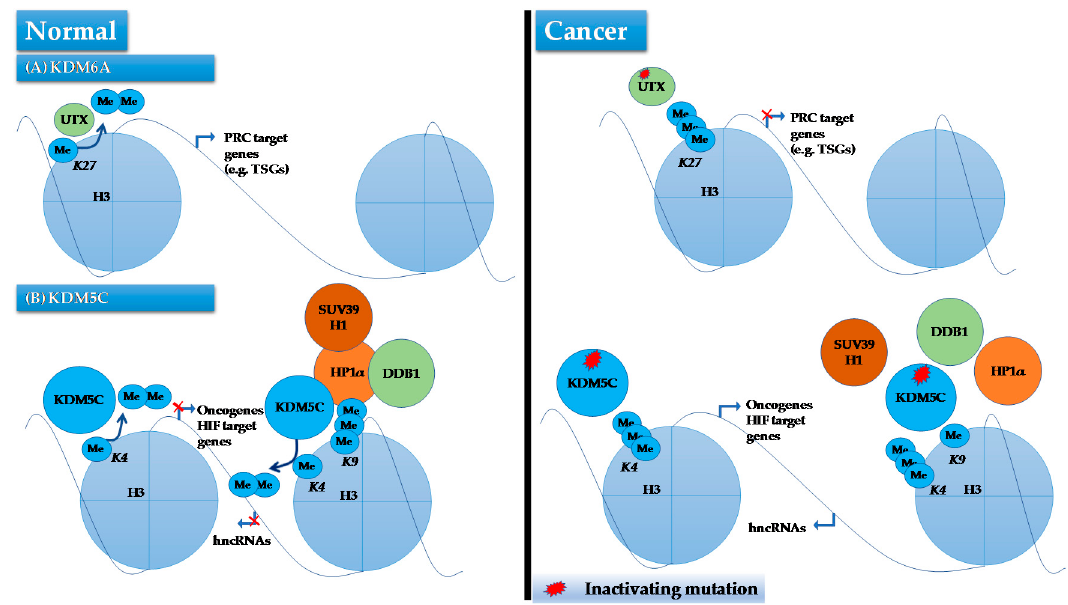
Figure 5. Functional consequences of KDM6A (or UTX) and KDM5C inactivation. ( A ) H3K27me3 is a suppressive marks associated with PRC target genes. UTX removes methyl groups from H3K27 and activates PRC target genes including multiple TSGs. Accordingly, loss of UTX in ccRCC contributes to trimethylation of H3K27, leading to inactivation of PRC target genes (e.g., TSGs) [27,144]; ( B ) KDM5C is a histone demethylase (HDM) that remove methyl groups from H3K4me3. H3K4me3 is a mark of active transcription and the removal of methyl group(s) by KDM5C results in suppression of expression of many genes including HIF target genes. Therefore KDM5C has been suggested to play a role in controlling hypoxia-driven gene expression. In addition, demethylation of H3K4me3 by KDM5C at heterochromatic sites is required for the recruitment of silencing complex consisted of SUV39H1, HP1 α , CUL4 and DDB1, which promotes tri-methylation of H3K9 for heterochromatin assembly and silencing of heterochromatic non-coding RNAs (hncRNAs). Inactivation of KDM5C in ccRCC, leads to the overexpression of genes that contribute to tumorigenesis including hypoxia-regulated genes, and uncontrolled expression of hncRNAs, which in turn triggers heterochromatin dysregulation and genome instability [147].